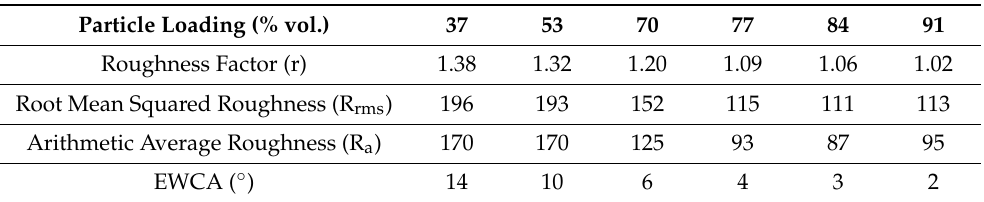
Table 4. Statistical Parameters for Several